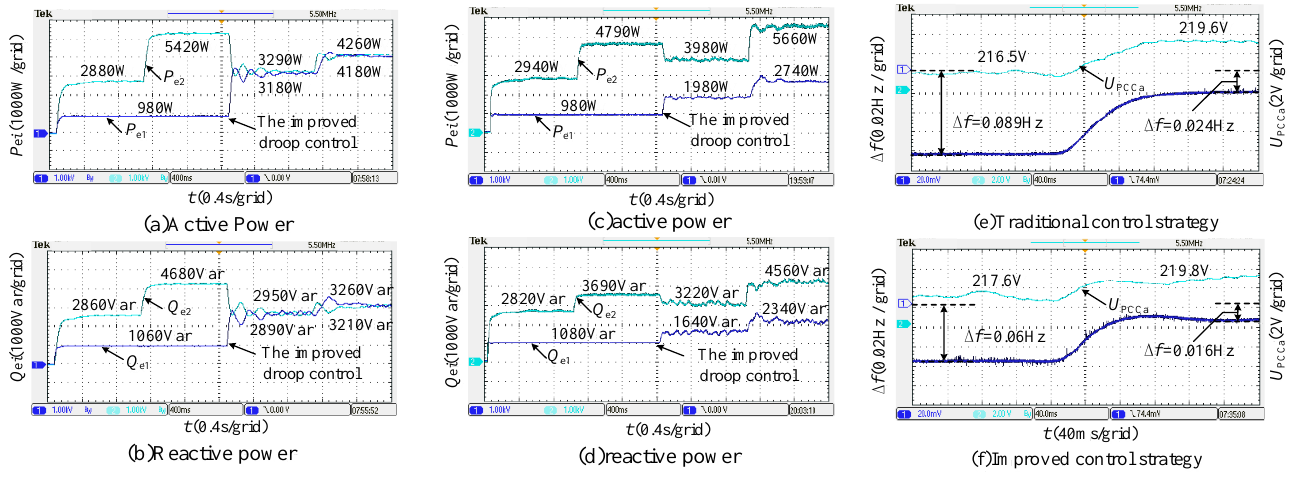
Figure 9. Waveforms of experimental results. ( a ) Active power output waveform when capacity setting is 1:1. ( b ) Reactive power output waveform when capacity setting is 1:1. ( c ) Active power output waveform when capacity setting is 2:1. ( d ) Reactive power output waveform when capacity setting is 2:1. ( e ) Output voltage U PCCa and frequency ∆ f with traditional control strategy. ( f ) Output voltage U PCCa and frequency ∆ f with improved control strategy.